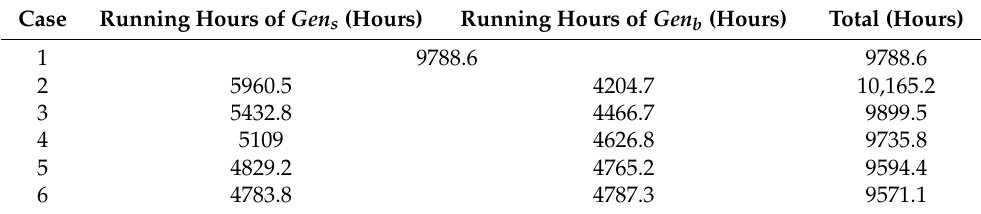
Table 7. Generator running hours in each